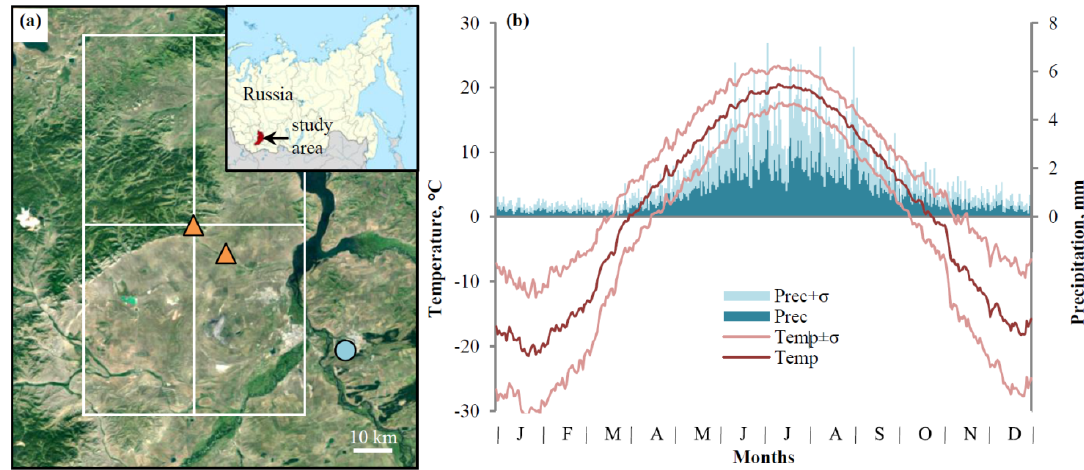
Figure 1. The study area: ( a ) a satellite map with two sampling sites marked by brown triangles, the Minusinsk weather station marked by a blue circle, the area of the Climate Research Unit Time-Series (CRU TS) grid climatic series integration (rectangles with spatial resolution of 0.5 ◦ × 0.5 ◦ ), and an inset map of the area location in the Asian part of Russia; ( b ) the climatic diagram of the temperature (lines) and precipitation (bars) daily series (1936–2017) from the Minusinsk weather station—the mean values are marked with darker shades, and the ranges of variation (standard deviations) are highlighted with lighter shades.